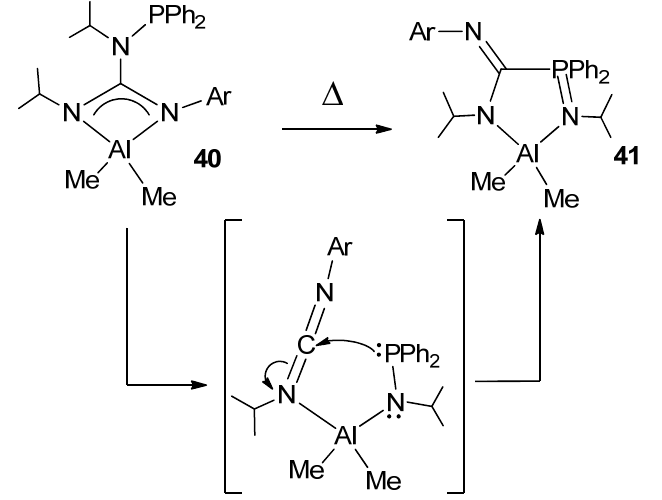
Figure 24. Rearrangement in phosphanoguanidinato derivatives.